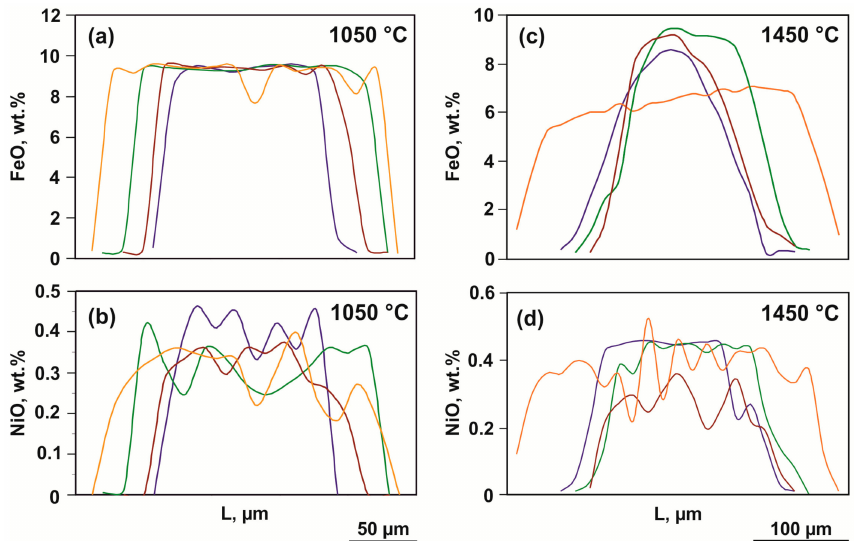
Figure 5. Representative profiles of the FeO and NiO distribution in recrystallized olivine (olivine-ankerite-sulfur system): ( a , b )—1050 ◦ C; ( c , d )—1450 ◦